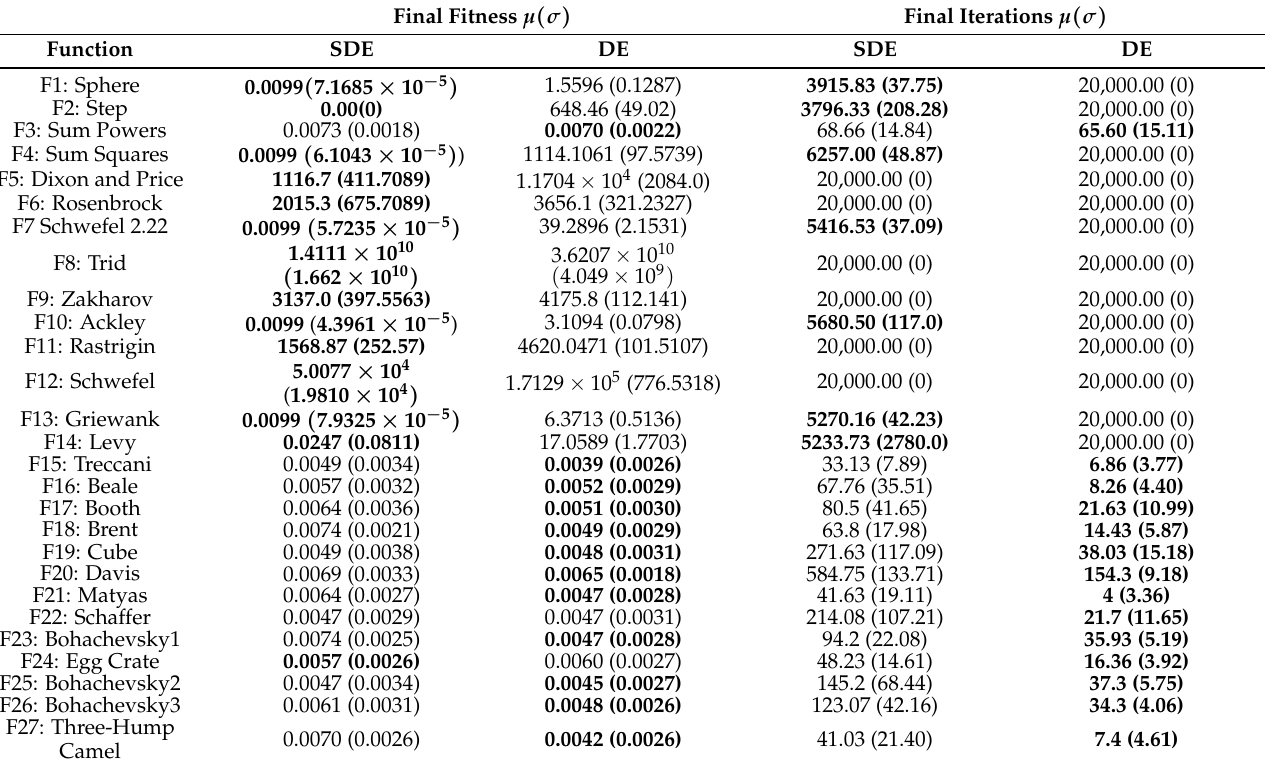
Figure 3. Comparison between the number of SDE and DE iterations. Table 9. Mean and averaged final fitness and iterations of DE and SDE ( N p = 256; D =